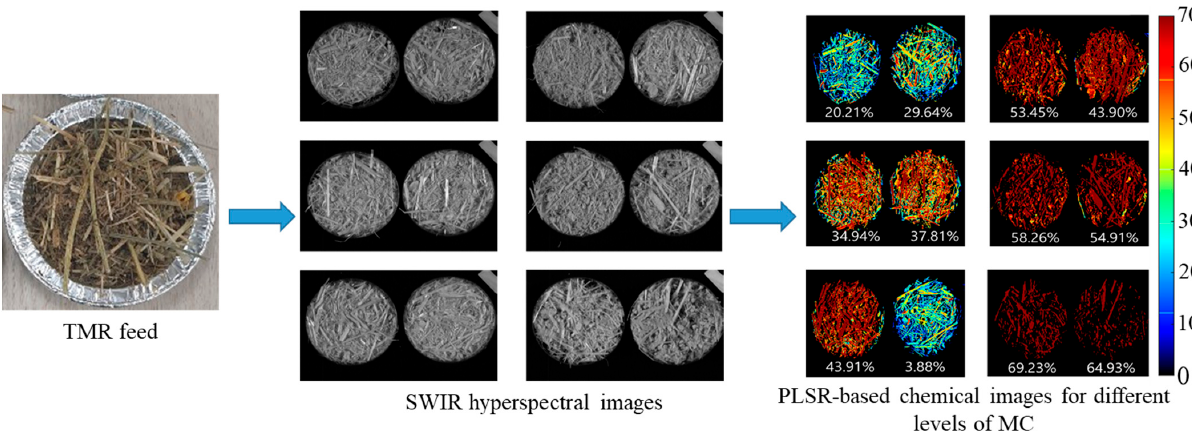
Figure 8. Original TMR feed, SWIR hyperspectral images of 1140 nm, and PLSR-based images for different levels of moisture content in TMR feed.